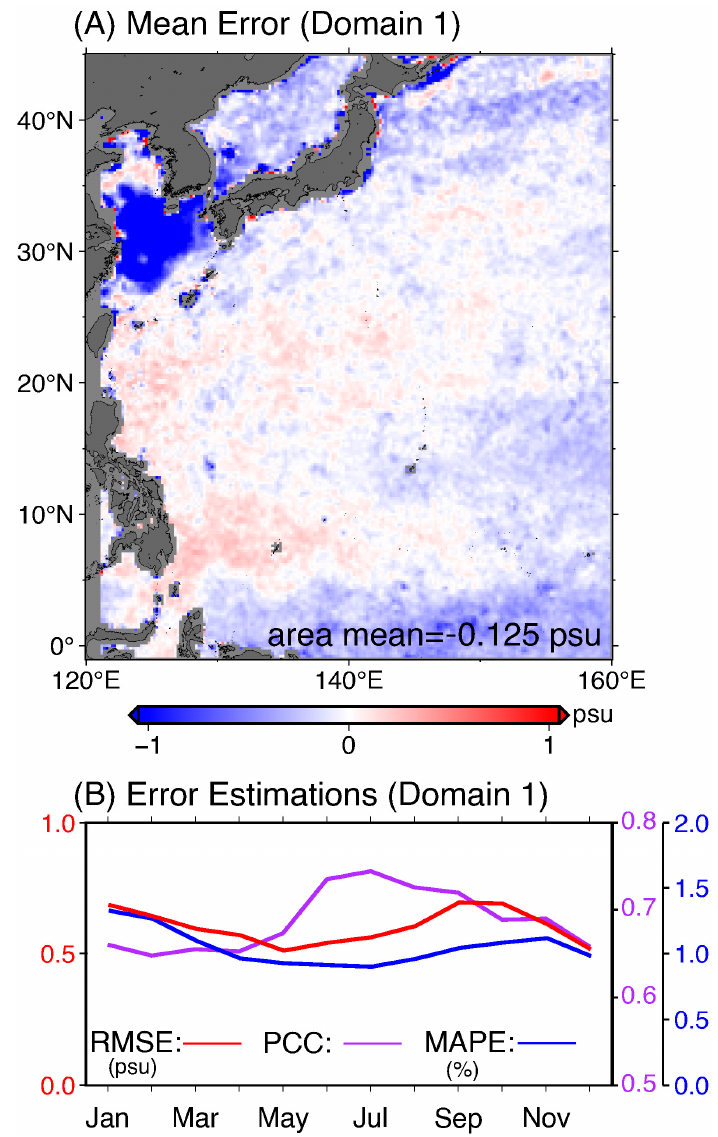
Figure 4. ( A ) Annual mean error of the predicted SSSs in 2021 over Domain 1 and ( B ) the monthly variations of the error estimations: root-mean-square error (RMSE), the pattern correlation coefficient (PCC), and mean absolute percentage error (MAPE).